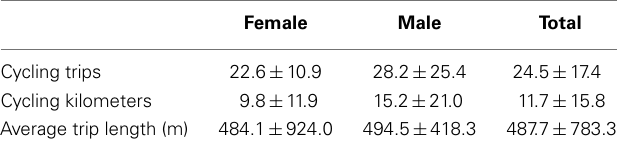
Table 2 |Transport cycling for 7days